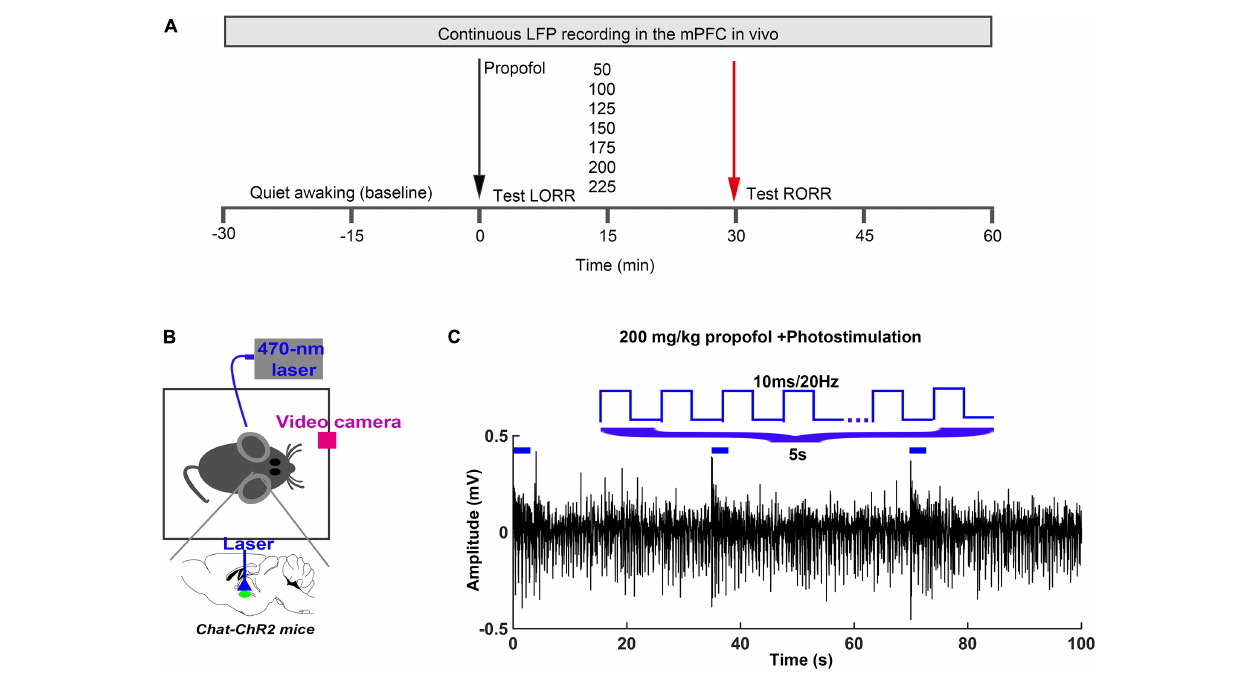
FIGURE 1 | Experimental procedures (A) In vivo LFP recording and behavioral test timeline. (B) Schematic of optogenetic stimulation of ChR2-expressing BF cholinergic neurons. (C) The parameter of light stimulation during the in vivo recording.